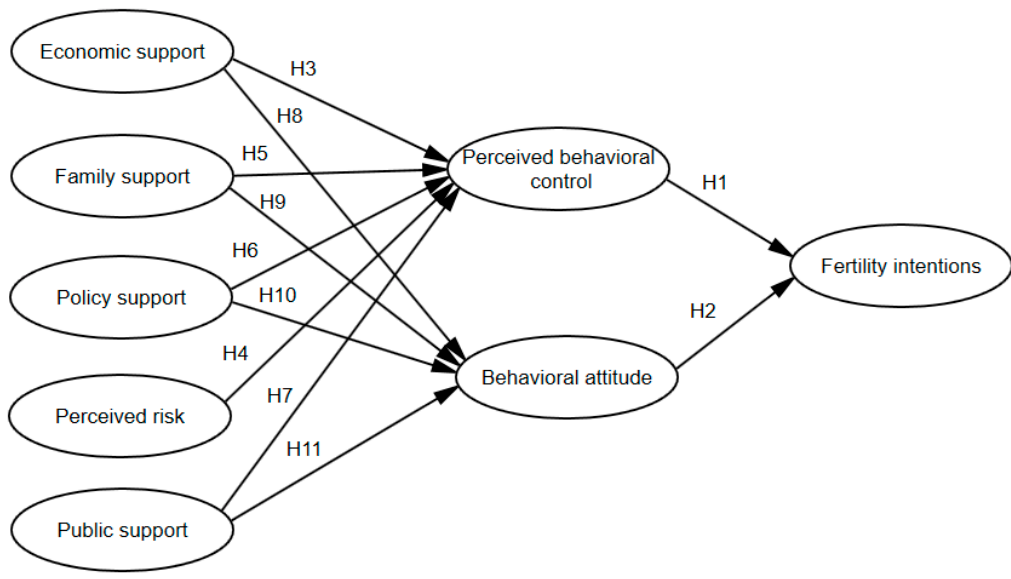
Figure 4. A theoretical model of fertility willingness of women of childbearing age.